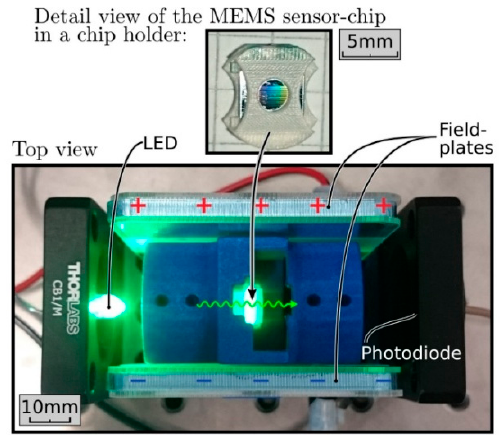
Figure 2. Photograph showing the measurement set-up for characterization of the transducer between an LED and a photo-diode. The transducer in a chip-holder is inserted into the 3D-printed blue colored body which serves also as spacer and fixation for the field